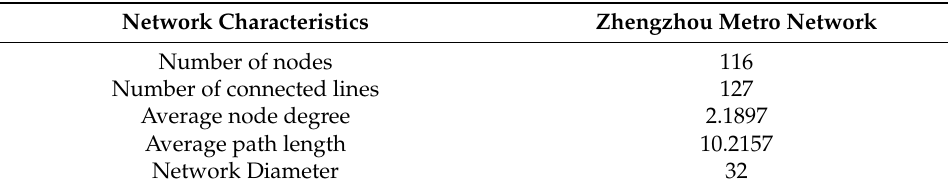
Table 2. Zhengzhou metro network characteristics